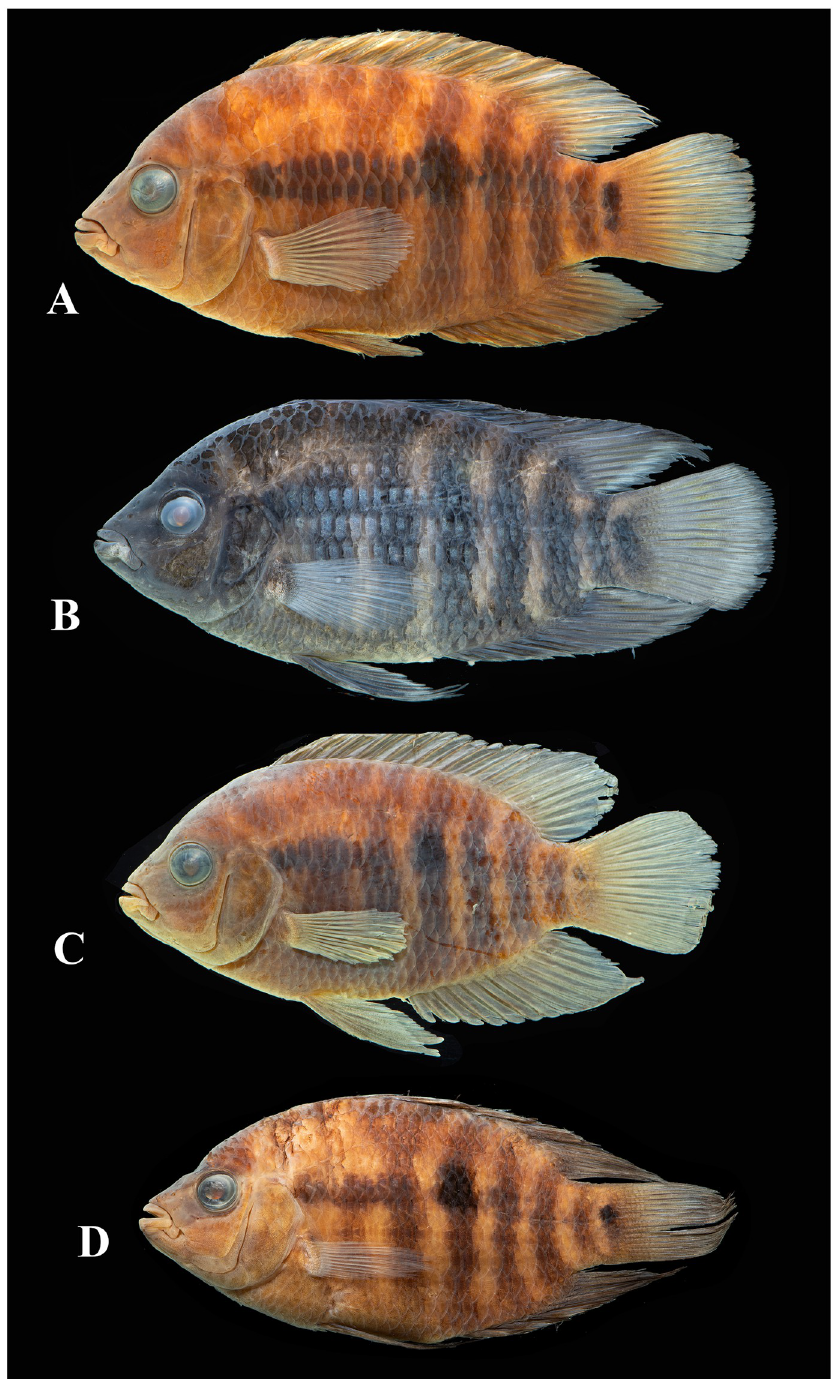
Fig 25. Australoheros sanguineus. A. holotype, adult female, 84.2 mm SL; MCP 14556; Brazil: Santa Catarina: Joinville: Rio Cubat ã o basin: Arroio Lindo. B. Adult male, 82.1 mm SL; MCP 40635; Joinville: Rio Cubat ã o Norte. C. Australoheros cf. sanguineus , adult male, 63.2 mm SL; Brazil: Santa Catarina: Petrolaˆndia: stream tributary of the Rio Perimbo on road between BR 282 and Petrolaˆndia (tributary of the Rio Itajai-Ac¸u); MCP 22440. D. Australoheros sanguineus , adult female, 69.0 mm SL; NUP 8861; Brazil: Parana´: Palmas: border with Pinh ã o: Rio Iratim, tributary of the Rio Iguac¸u.